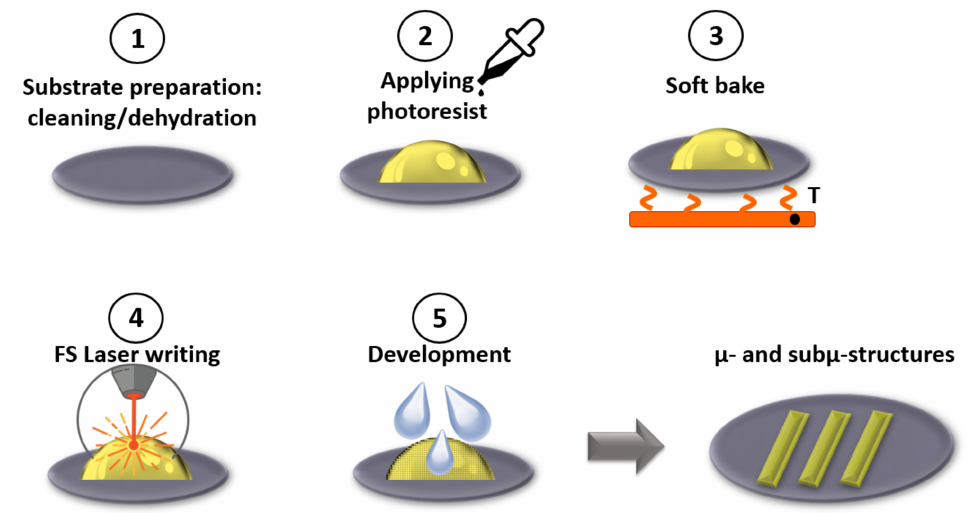
Figure 2. Schematics of 3D laser lithography 3DLL technology, which is based on next steps: substrate preparation, applying photoresist by pipet, soft bake on the hot plate, femto-second laser writing, and development in the liquid developer. The development step (5) reveals the final free-standing micrometer or sub-micrometer size